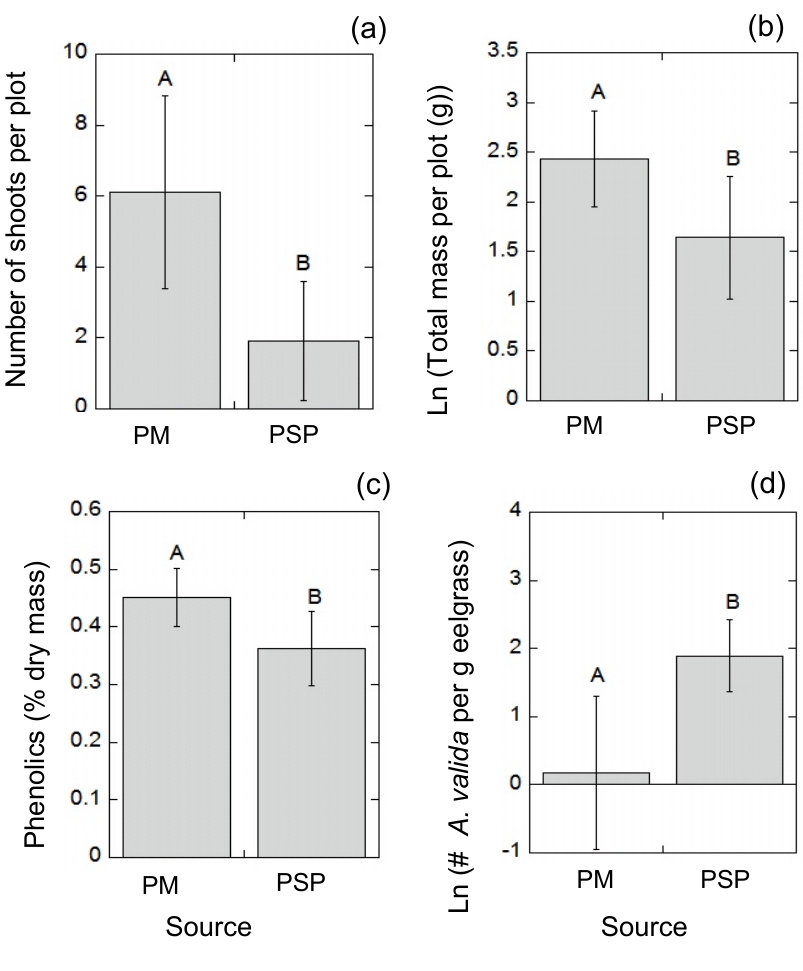
Figure 6. Effects of eelgrass source in the field experiment on eelgrass ( a ): shoot density, ( b ) dry mass, ( c ) total phenolic concentration, and ( d ) abundance of Ampithoe valida . Error bars are 95% confidence intervals. Different letters indicate statistically significant differences. Sources were PM = Point Molate and PSP = Point San Pablo. n = 10 except for PSP in ( b–d ), where n = 5 (only those plots with surviving